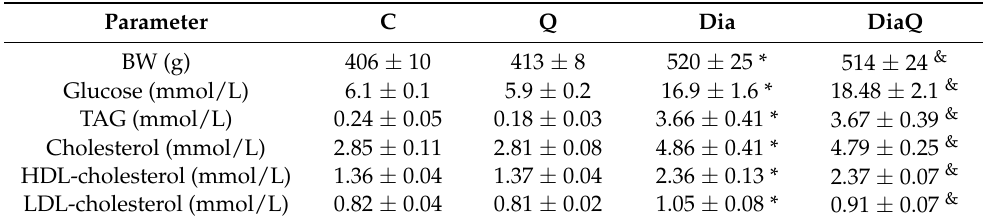
Table 1. Effects of vehicle and quercetin treatment on biometric and biochemical characteristics in control lean and obese diabetic one-year-old Zucker Diabetic Fatty (ZDF) rats. Abbreviations: C, lean vehicle-treated controls; Q, quercetin-treated lean rats; Dia, vehicle-treated obese diabetic rats; DiaQ, quercetin-treated obese diabetic rats; BW, body weight; TAG, triacylglycerides; HDL, high-density lipoprotein; LDL, low-density lipoprotein. Data are presented as means ± SEM, n = 12–14. Significant differences were evaluated by t -test, * p < 0.05 vs. control lean vehicle-treated rats, & p < 0.05 vs. control lean quercetin-treated